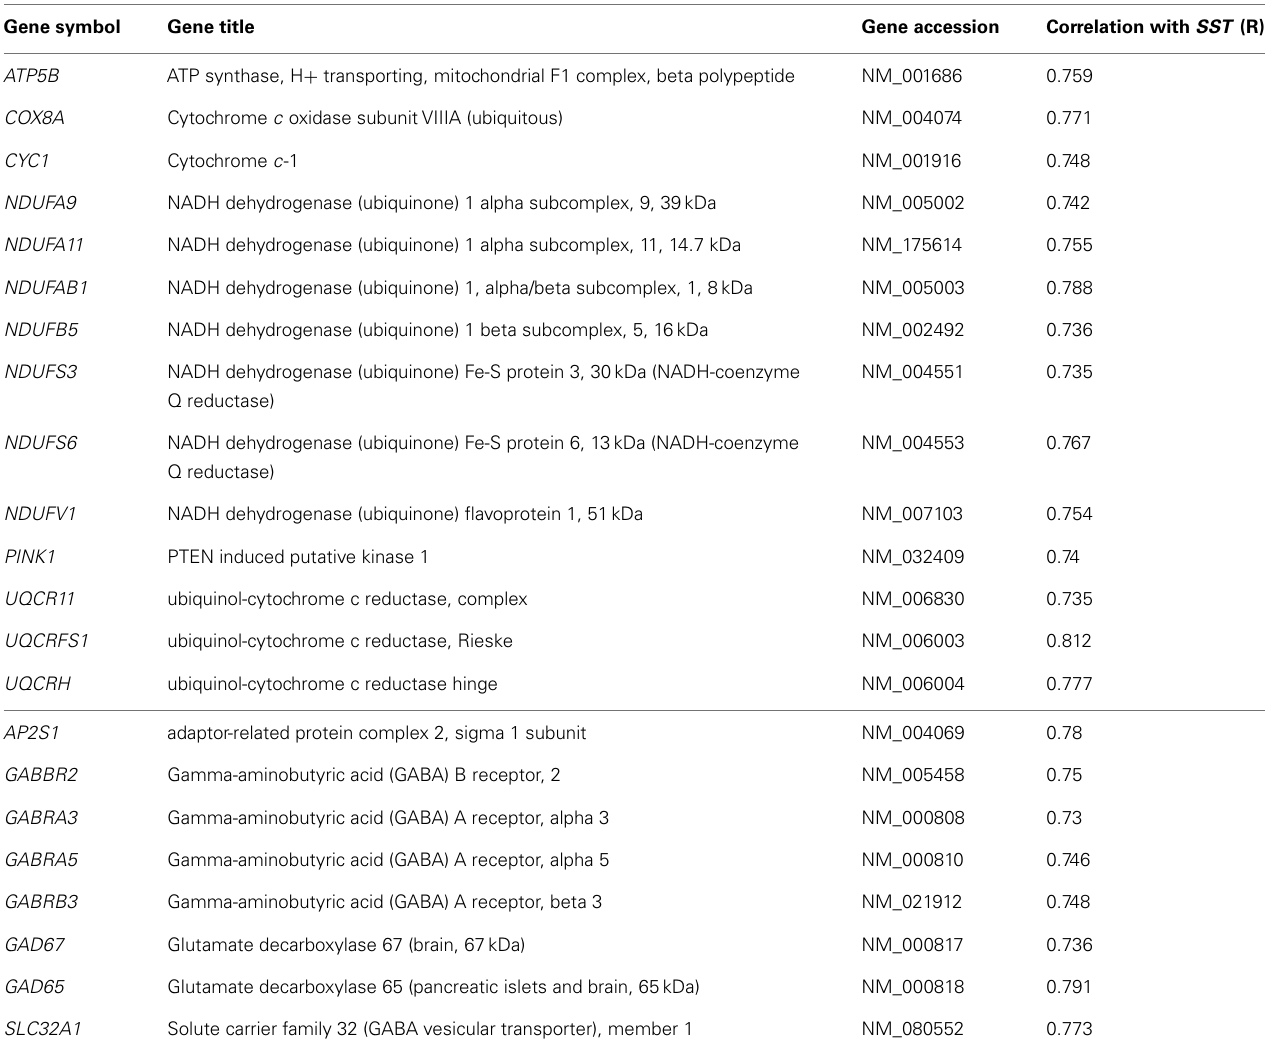
Table 5 | (Top) Mitochondrial dysfunction-related genes with expression correlated with SST (14/174 genes) in human frontal cortex. (Bottom) GABA receptor signaling-related genes with expression correlated with SST (8/56